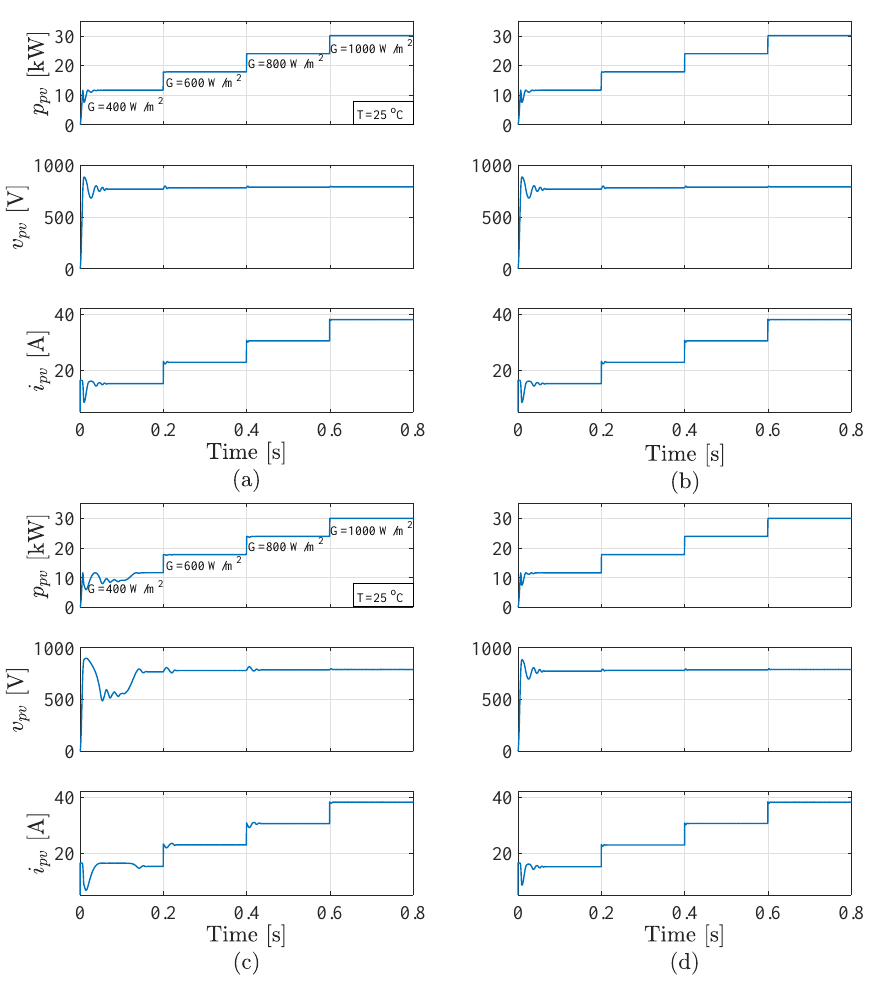
Figure 13. MPPT performance at step changes of radiation: ( a ) P&O method; ( b ) modified P&O; ( c ) multi-power-sample method; ( d ) the proposed model-based